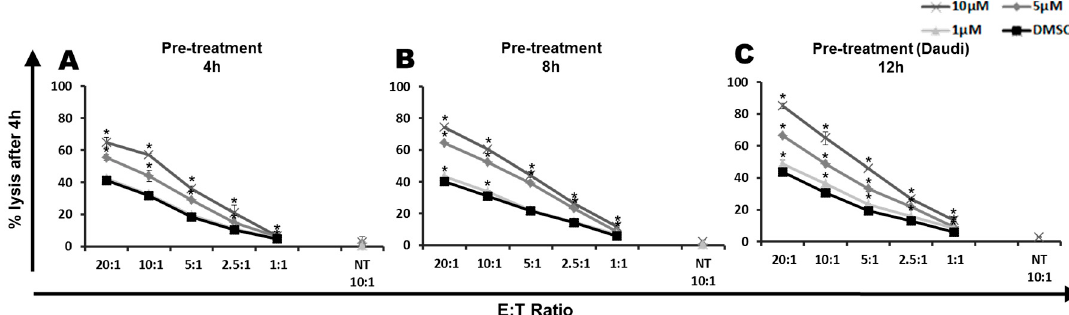
Figure 3. Pretreatment of lymphoma cells with PipFcB sensitizes lymphoma cells to lysis by CARTs. CD19 + Daudi cells were first incubated with di ff erent concentrations of PipFcB (10, 5, and 1 µ M) or DMSO (vehicle) for 4 h ( A ), 8 h ( B ), or 12 h ( C ). Afterwards, CD19-specific CARTs in di ff erent e ff ector to target (E:T) ratios (20:1, 10:1, 5:1, 2.5:1, 1:1) or non-transduced T cells (NT) were added and co-incubated with tumor cells for 4 h. Cytotoxicity was determined by 51 Cr release assay. Synergistic e ff ects of CARTs with PipFcB were seen in all concentrations (1–10 µ M) and pre-treatment durations (4–12 h). All experiments were performed in triplicates. Mean values were calculated for each group; error bars indicate standard deviation (* p < 0.05).